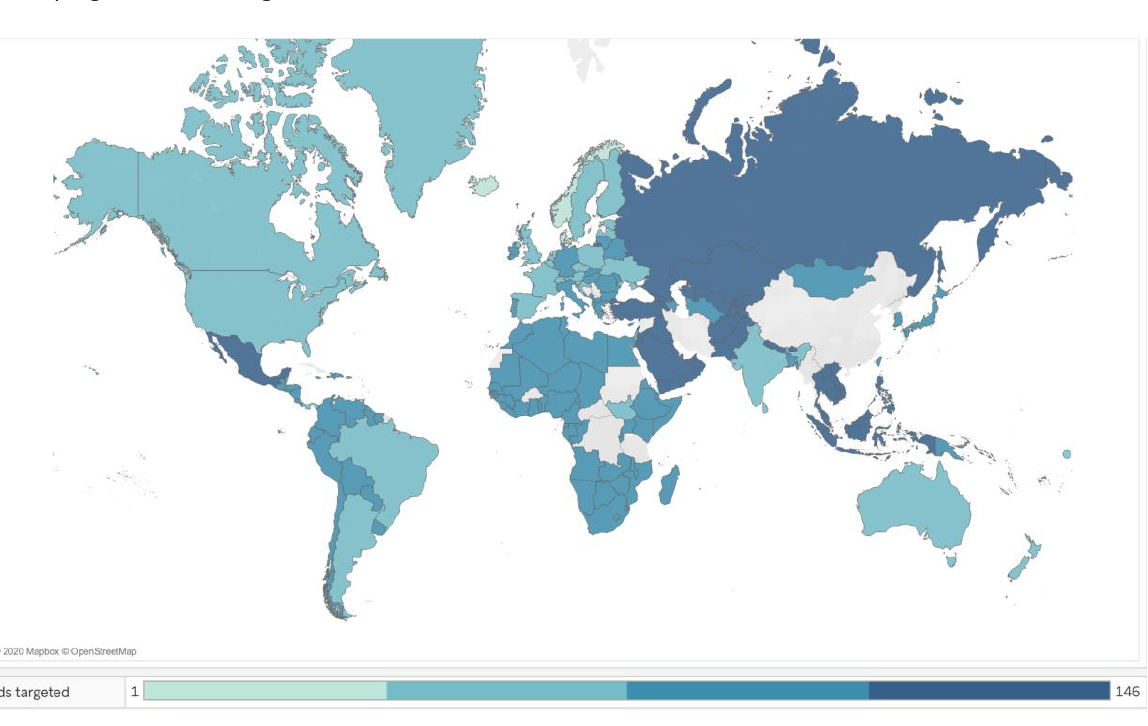
Figure 7 : Map of Chinese state media Facebook ad targeting by country between January 1, 2019 and March 29, 2020. Darker color indicates a higher number of ads targeted at a certain country (Lightest color: 1-36 ads; 37-73, 74-109, 110-146). Gray indicates no ads targeted at a certain country. An individual ad was often targeted at more than one